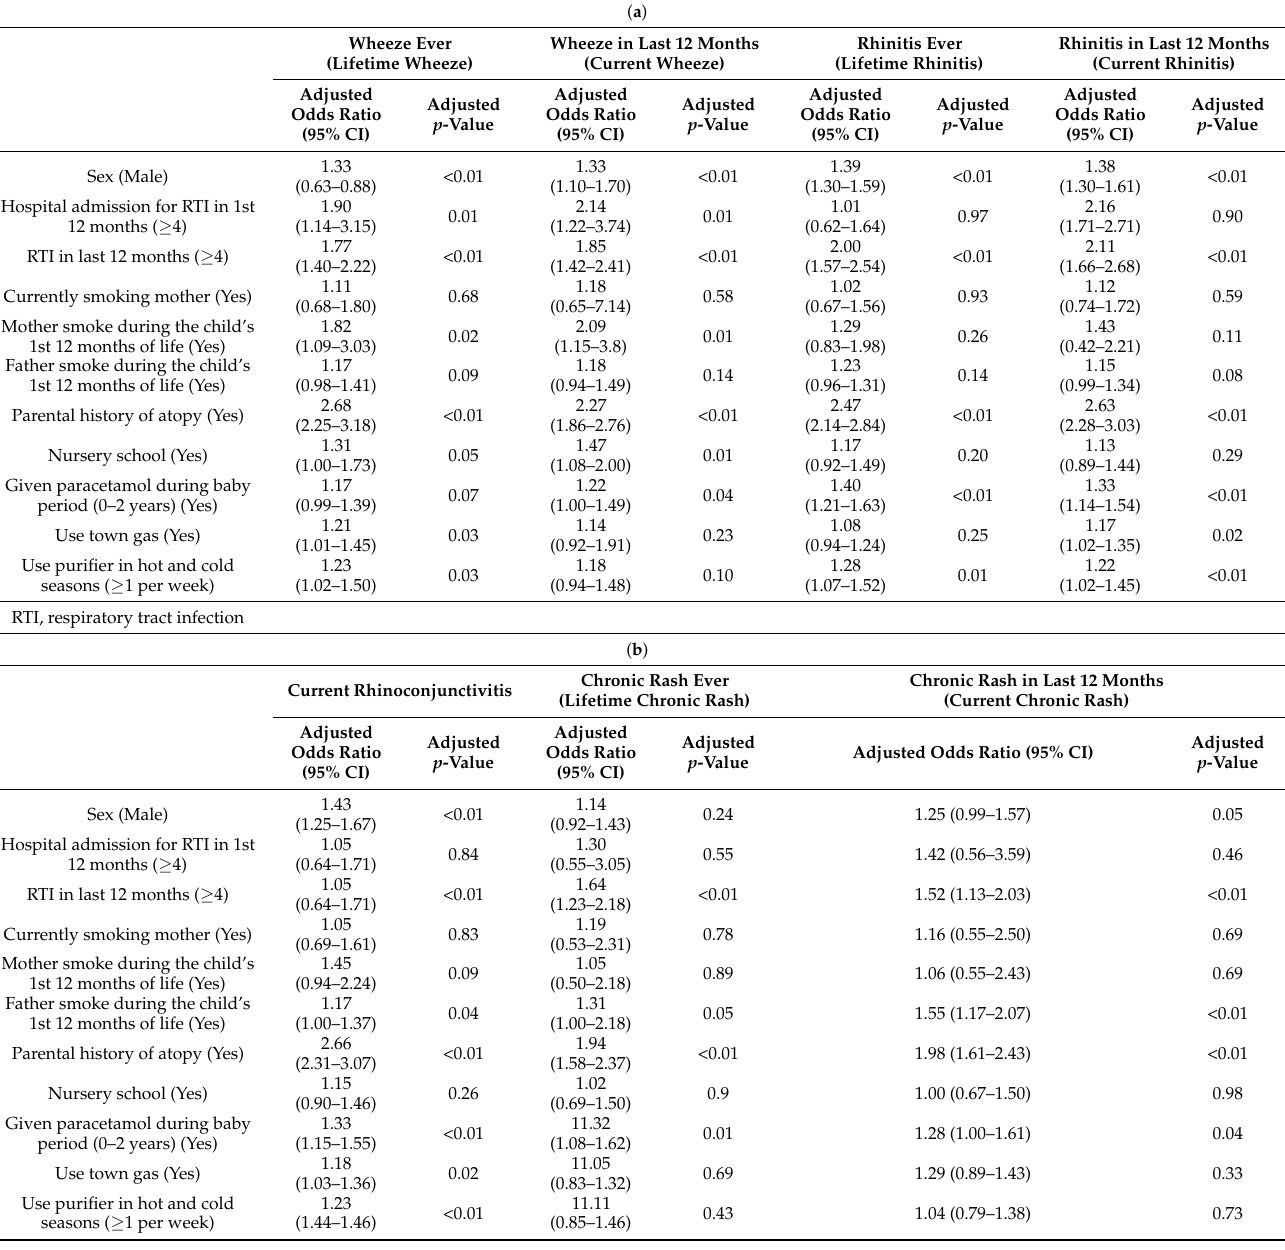
Table 4. ( a ) Basic model for the associations between risk factors and 7 health outcomes in the 3rd survey 2015–2016 by multiple logistic regression. ( b ) Basic model for the associations between risk factors and 7 health outcomes in the 3rd survey 2015–2016 by multiple logistic